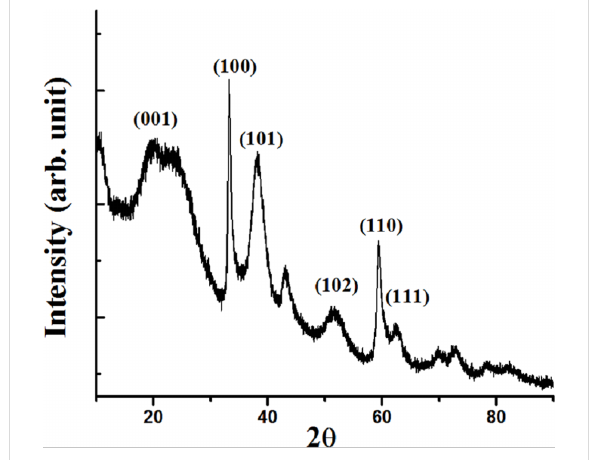
Figure 5: XRD of Ni(OH) 2 /RGO, prepared